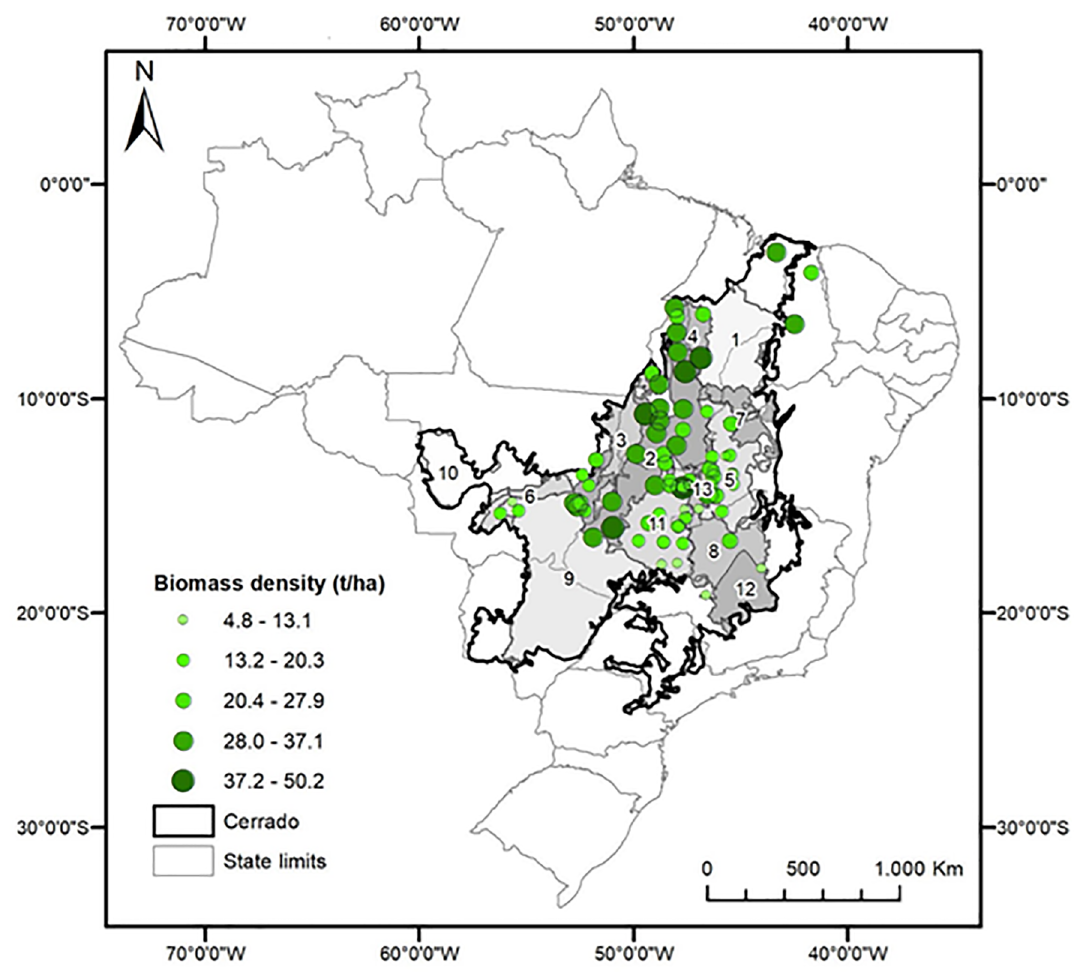
Fig 5. Distribution of tree aboveground biomass density of cerrado sensustricto vegetation in cerrado (estimated with model 11), using individual-tree data from 77 sites. Numbers indicate ecoregions: 1 = Alto Paranaı´ba, 2 = Araguaia Tocantins, 3 = Bananal, 4 = Bico do Papagaio, 5 = Chapad ã o do S ã o Francisco, 6 = Depress ã o Cuiabana, 7 = Depress ã o do Parnagua´, 8 = Paracatu, 9 = Parana´ Guimar ã es, 10 = Parecis, 11 = Planalto Central, 12 = S ã o Francisco Velhas, 13 = V ã o do Paran ã . Delimitation of Cerrado biome and ecoregions was obtained from IBGE [59] and Arruda et al. [9], respectively.